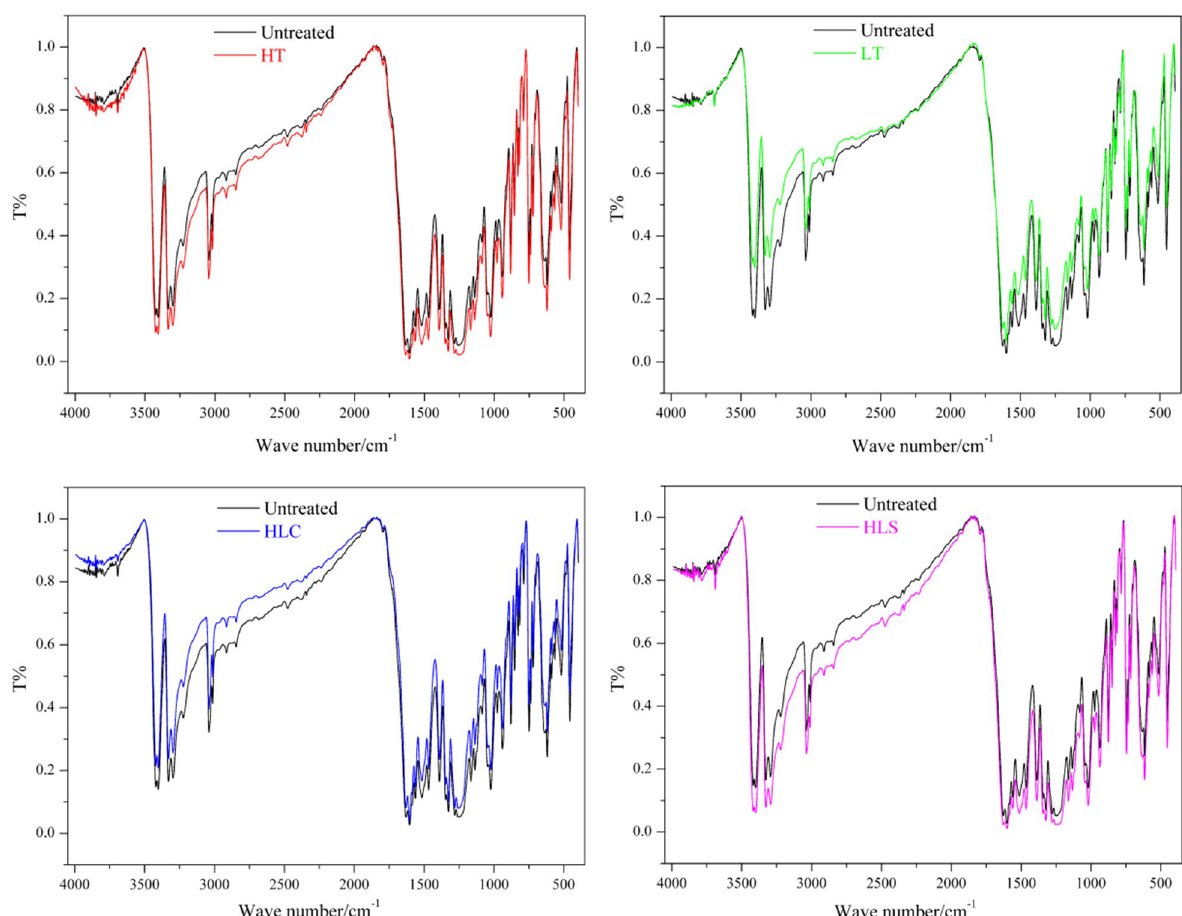
Figure 4. IR spectroscopies of HNIW/FOX-based PBX samples.